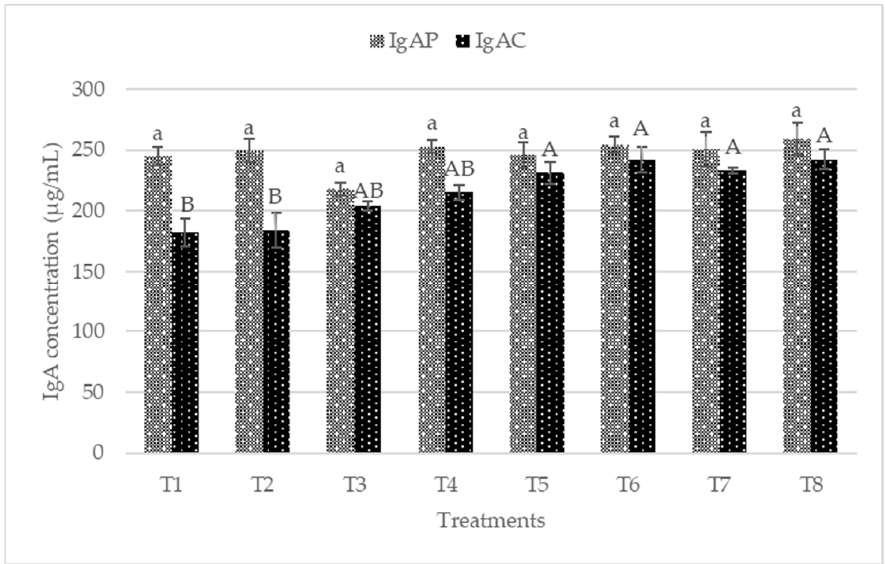
Figure 2. Plasma and Colon mucosa immunoglobulin A (IgA) concentrations of broiler chicken fed postbiotics and paraprobiotics. Bars with the same letters are significantly different ( p > 0.05) for Plasma IgA, while bars with different letters differs significantly ( p < 0.05) for Colon mucosa IgA, n = 6. T1 = negative control (Basal diet), T2 = positive control (Basal diet + 0.01% ( w / w ) Oxytetracycline), T3 = Basal diet + 0.2% ( v / w ) postbiotic TL1, T4 = Basal diet + 0.2% ( v / w ) postbiotic RS5, T5 = Basal diet + 0.2% ( v / w ) paraprobiotic RG11, T6 = Basal diet + 0.2% ( v / w ) postbiotic RI11, T7 = Basal diet + 0.2% ( v / w ) paraprobiotic RG14, T8 = Basal diet + 0.2% ( v / w ) paraprobiotic RI11. IgAP = Plasma immunoglobulin A, IgAC = Colon mucosa immunoglobulin A.